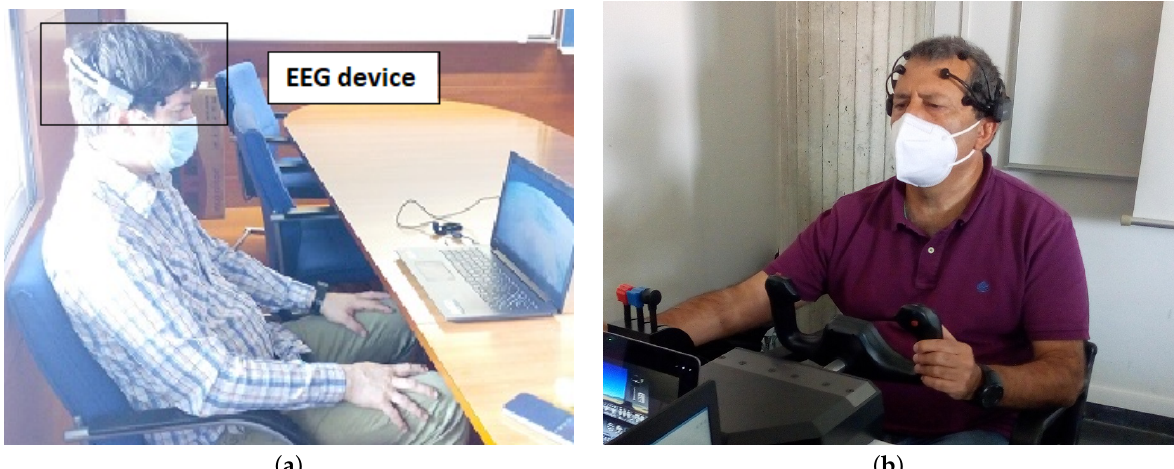
Figure 1. Data collection with Emotiv Epoc+ headset. ( a ) A volunteer during a n-back-test and ( b ) a pilot during simulated flight